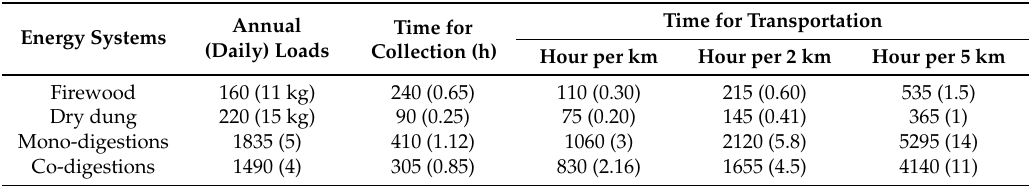
Table 4. Average time spent annually and daily on collection and transportation of biomass and water in different energy systems in hours.